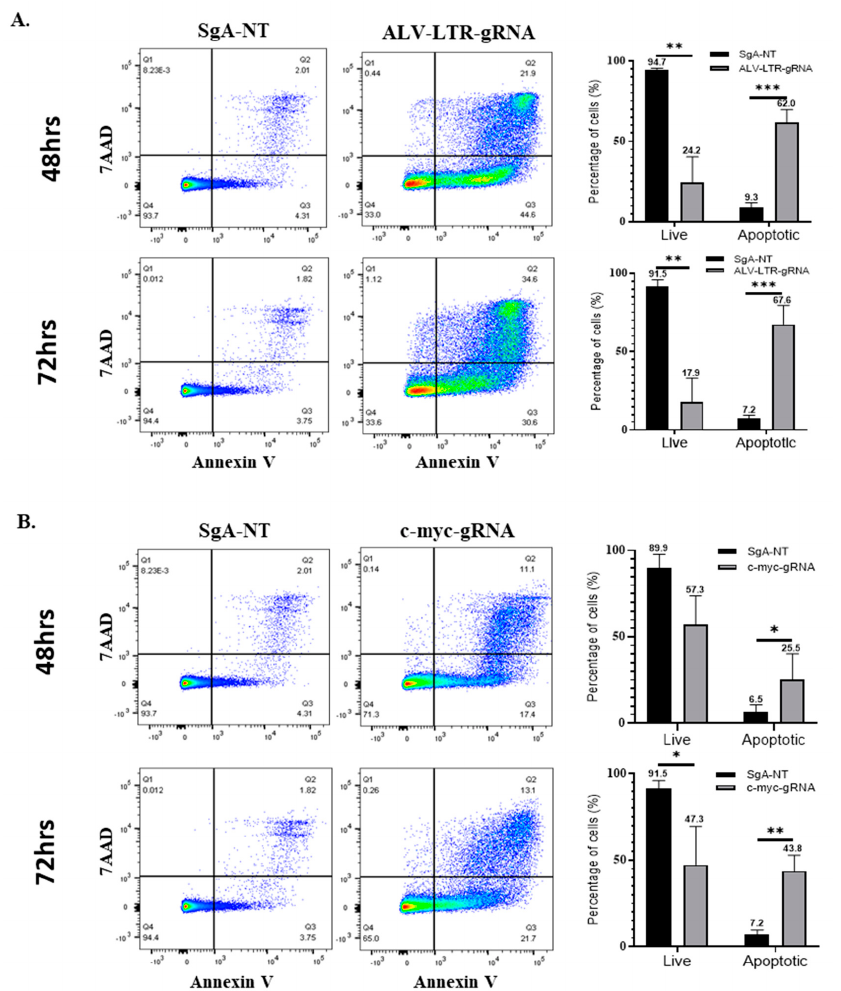
Figure 3. Apoptosis Assay and viability assay of gRNA-transfected cells. SgA-NT (left panels) or gRNAs targeting ALV-LTR ( A ) and c-myc ( B ) (middle panels) transfected cells were stained with Annexin-V-FITC and 7AAD at 48 h (upper panels) and 72 h (lower panels) post transfection and analyzed in FlowjoX with data collected on a BD Bioscience LSR Fortessa. The histogram (right pan- els) shows the percentage of live and apoptotic cells calculated from the flow cytometry data. Each experiment has been performed a minimum of three times, multiple t -tests have been performed, and the statistical significance was calculated using the Holm-Sidak method. Asterisk (*) indicates statistically significant differences between gRNA-edited cells and SgA-NT cells at different time points. * p <0.05; ** p < 0.01; *** p < 0.001.